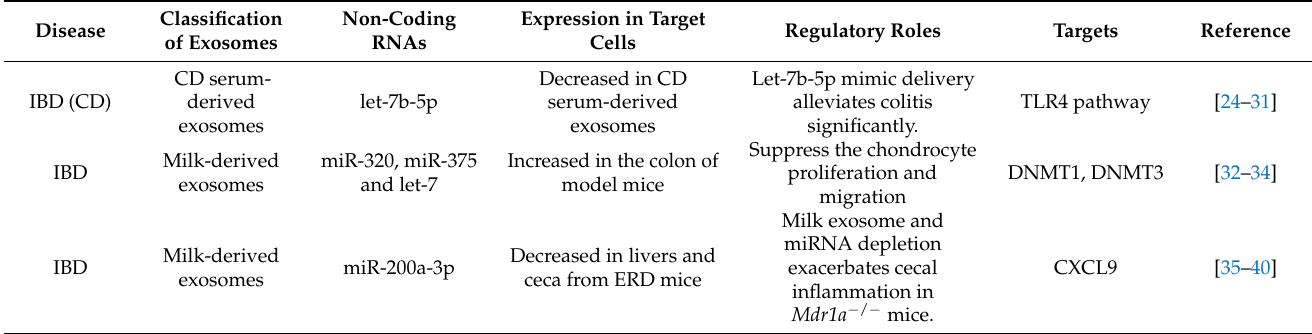
Table 1. Exosomes and inclusions reported in